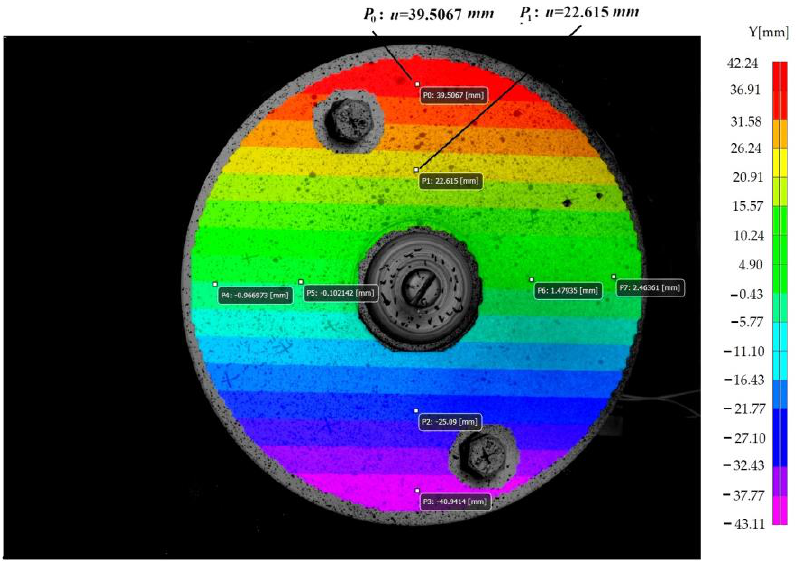
Figure 10. The sprayed small plastic disk‘s frontal view, together with the area of interest and the vertical coordinates of the selected points (mainly presented interest P 0 and P 1